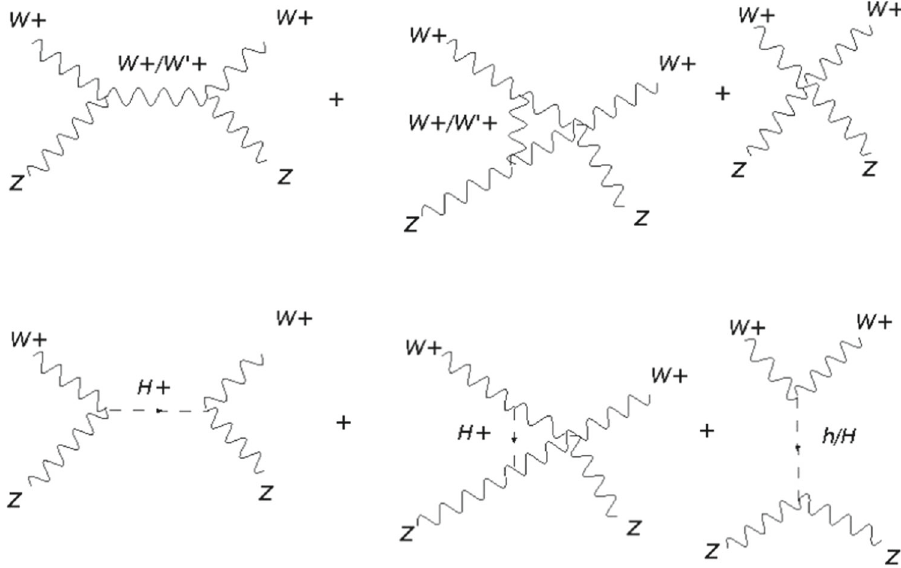
Fig. 3 Gauge Boson and Scalars mediated Feynman diagrams contributing to the scattering process W + Z → W +